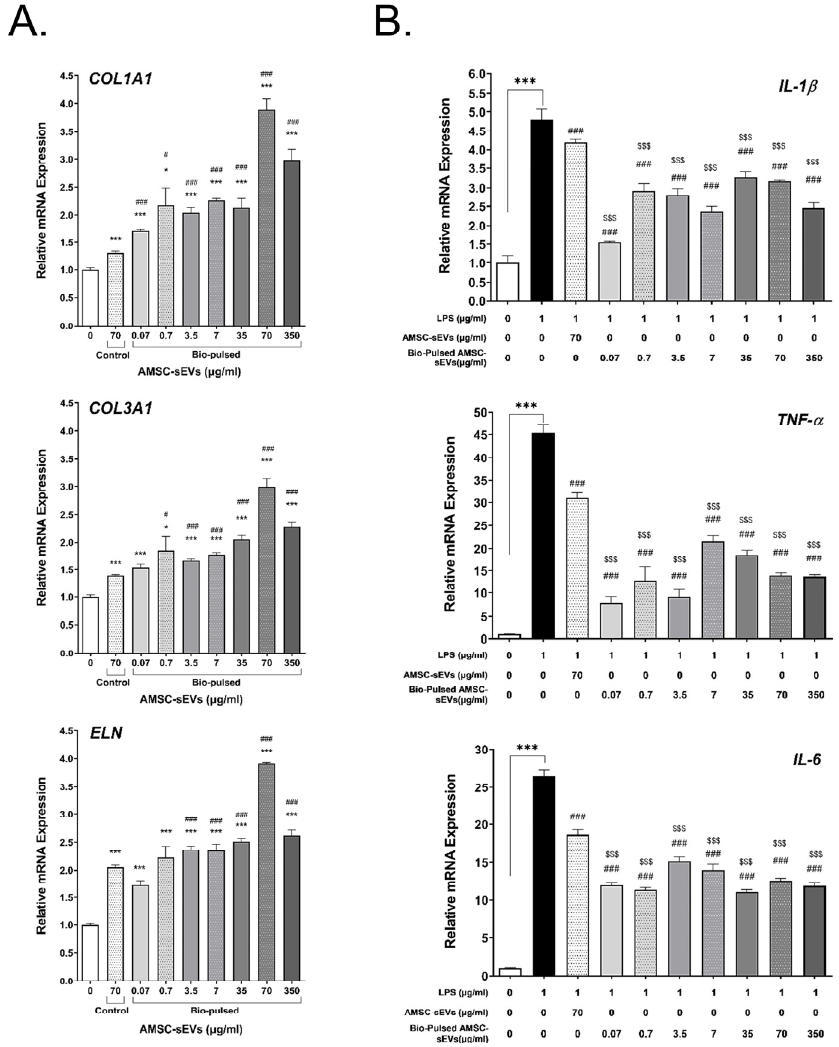
Figure 5. Bio-pulsed avian-derived mesenchymal stem cell (AMSC) sEVs enhanced collagen and elastin expression but ameliorated lipopolysaccharide (LPS)-induced inflammation on human skin fibroblasts (HSFs). ( A ) Bio-pulsed AMSC-sEVs upregulated the expression of COL1A1 , COL3A1 , and ELN compared with control AMSC-sEVs in HSFs after treatment for 2 days. (n = 4, data are expressed as the mean ± standard deviation; * p < 0.05, *** p < 0.001, compared with 0 μ g/mL; # p < 0.05, ### p < 0.001, compared with the control AMSC-sEVs group). ( B ) After treatment with control AMSC-sEVs or bio-pulsed AMSC-sEVs for 24 h, LPS-induced expression of cytokines, interleukin (IL)-1 β , tumor necrosis factor- α , and IL-6 were ameliorated. (n = 4, data are expressed as the mean ± standard deviation; * p < 0.05, *** p < 0.001, compared with 0 μ g/mL; ### p < 0.001, compared with the LPS group; $$$ p < 0.001, compared with the control AMSC-sEVs group).